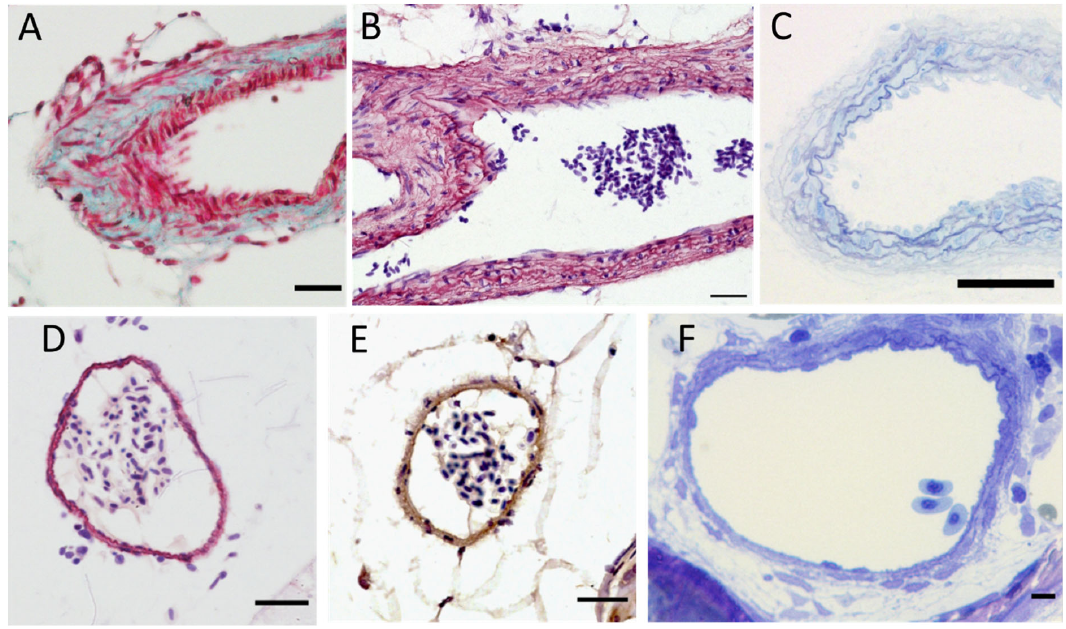
Figure 4. Elastin content of zebrafish major arteries. ( A – C ) Ventral aorta sections stained with Masson-Goldner trichrome ( A ), orcein ( B ) or by toluidine blue on a semi-thin section ( C ); scale bar = 10 µ m; ( D – F ) dorsal aorta sections stained with orcein ( D ), by immunohistochemistry using anti-elastin antibodies ( E ) or by toluidine blue on a semi-thin section ( F ); scale bar = 10 µ m ( A , B ); 5 µ m ( C – F ). Magnification: 400 × ( A – E ); 1000 × ( F